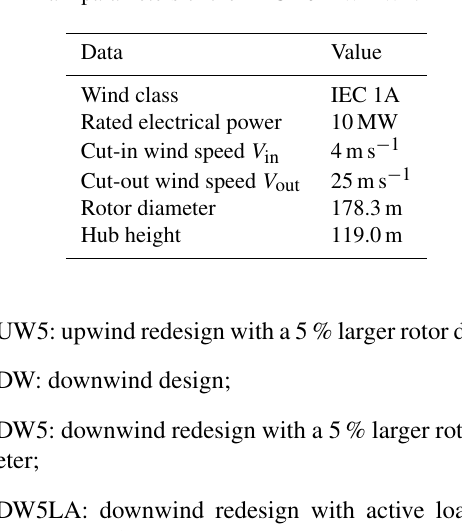
Table 1. Main parameters of the DTU 10MW